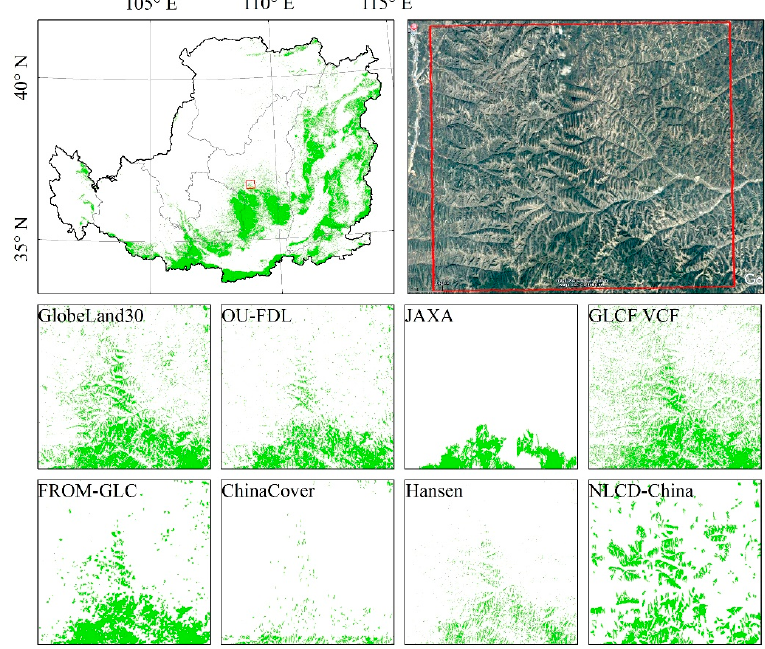
Figure 4. A zoom-in comparison of eight forest products across a case region with fragmented landscapes.